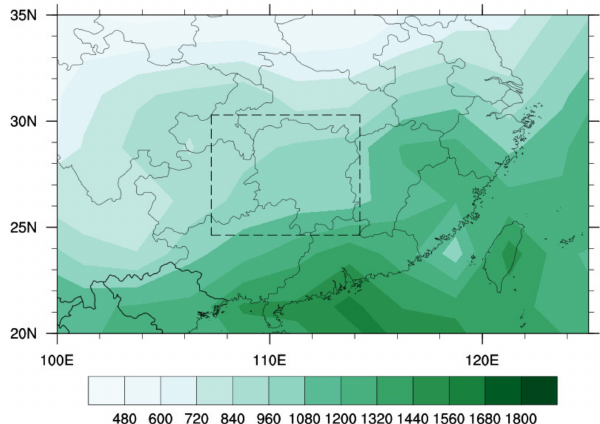
Figure 1. Accumulated precipitation in the flood season from 2006 to 2019, unit: mm; The dotted box